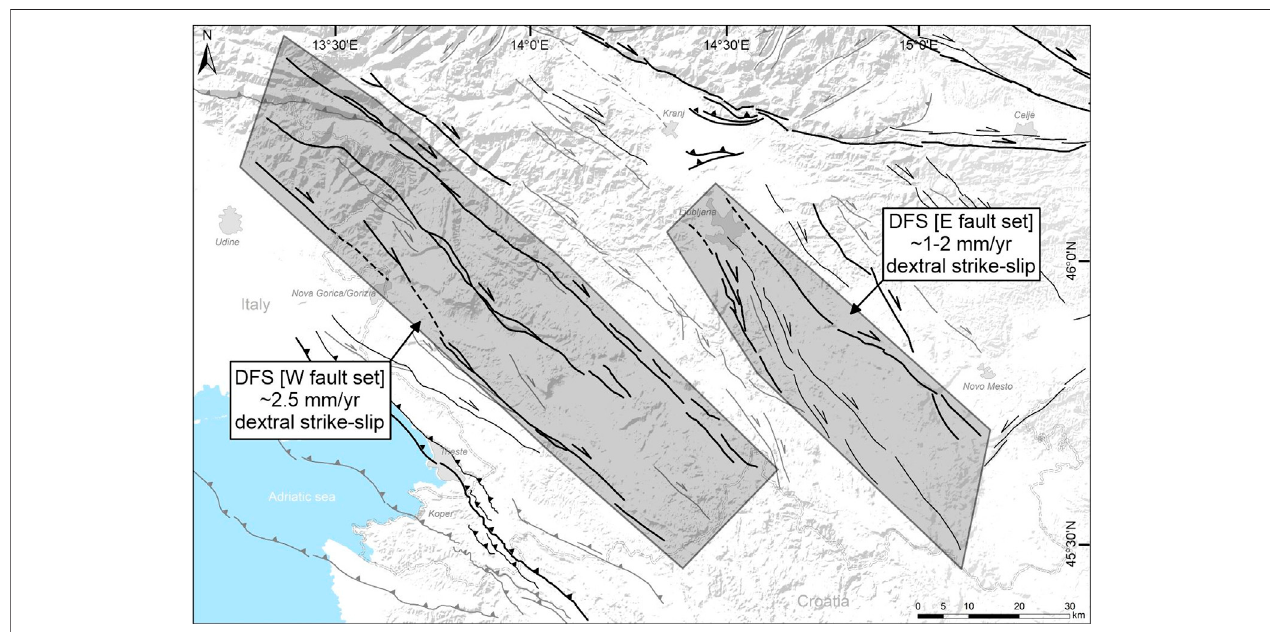
FIGURE8| Dinaric faultsystem western and eastern sets indicatingtwocorridors ofcomparatively high slip rates. Thewestern faultsetaccommodates up to (cid:1) 2.5 mm/yr of dextral strike slip, while the eastern fault set accommodates up to (cid:1) 1 – 2 mm/yr of dextral strike slip. Slip rates on other faults within the system are estimated to be an order of magnitude lower.